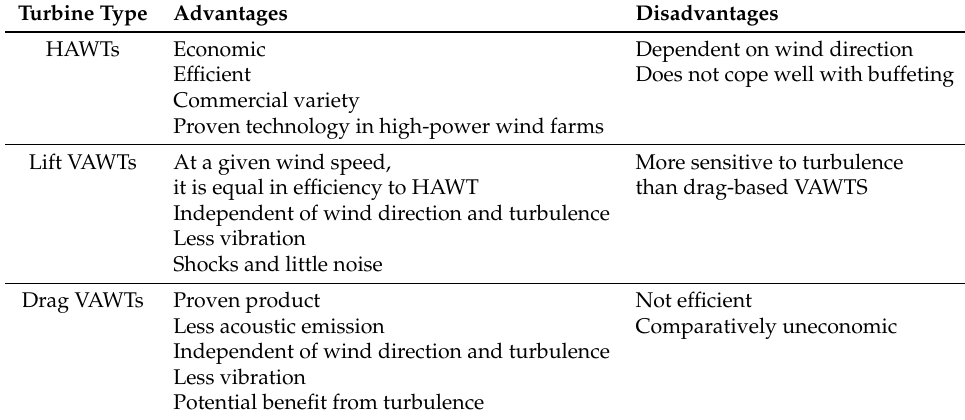
Figure 3. Examples of current turbines: horizontal-axis wind turbines (HAWTs) (1) and vertical-axis wind turbines (VAWTs) (2). Data source: [40–42]. Authors’ own elaboration. Table 2. Advantages and disadvantages of urban wind